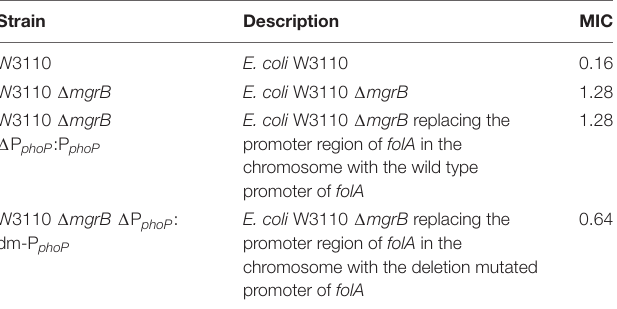
TABLE 5 | MICs ( µ g ml − 1 ) to TMP in different strains of E. coli K-12